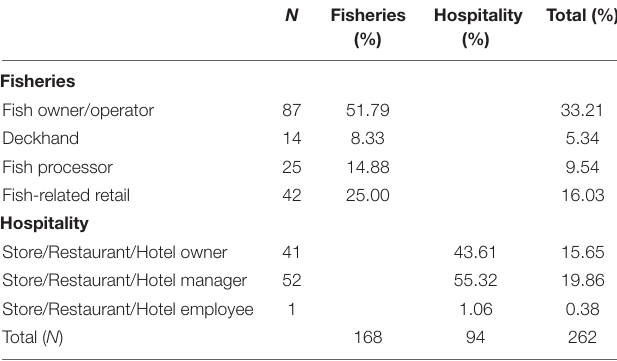
TABLE 2 | Number of survey respondents by occupation.